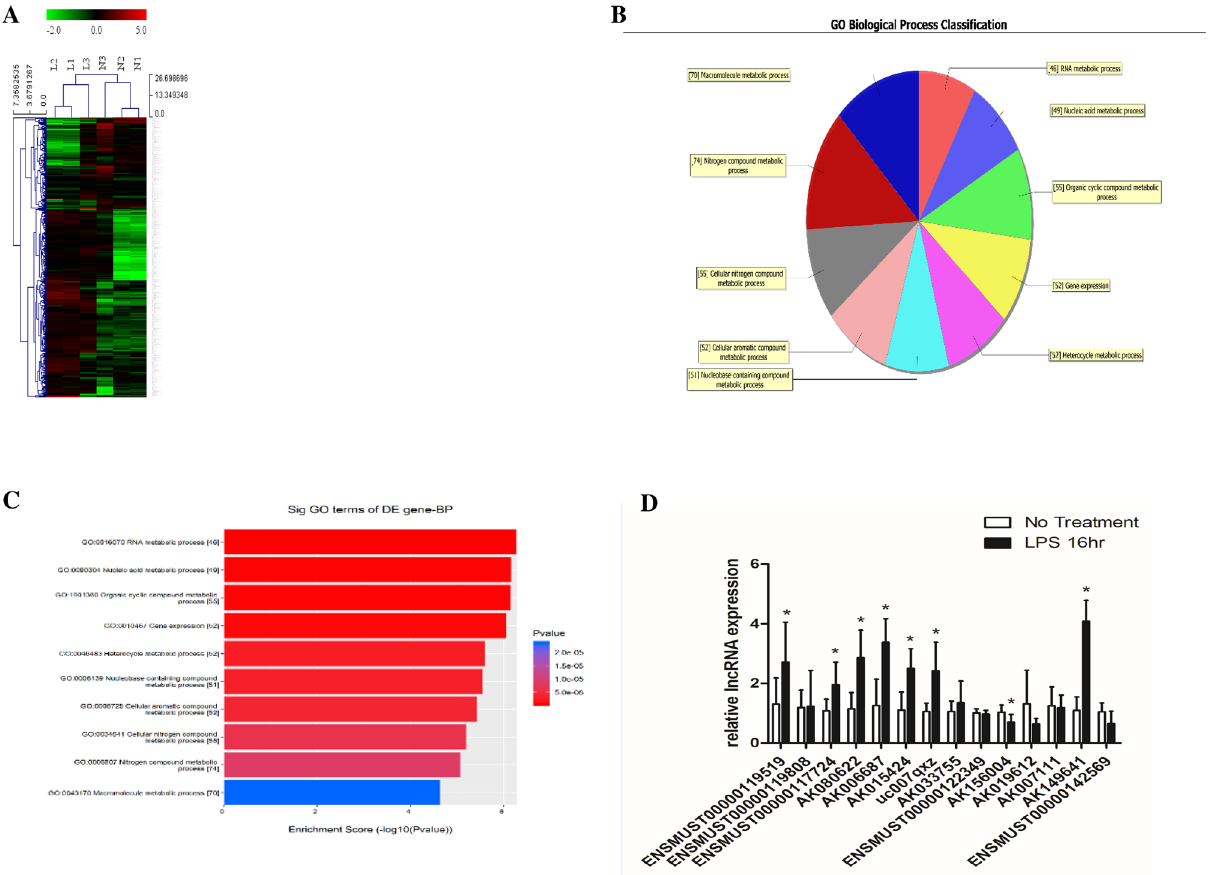
Figure 1. Differentially expressed lncRNAs between LPS-stimulated and normal control P815 mast cells. ( A ) Heat map of lncRNAs expressed in LPS-stimulated and normal control cells. ( B – C ) Gene ontology analysis. ( D ) Expressions of 14 candidate lncRNAs in P815 mast cells upon stimulation with LPS. (N1, N2, and N3: normal control P815 mast cells; L1, L2, and L3: LPS-stimulated P815 mast cells) (* P < 0.05, n =